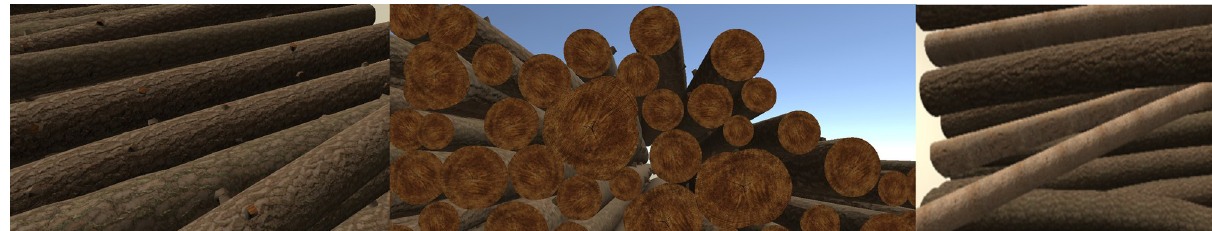
Fig 7. Simulation details: Branch stubs, butt swells, debarked logs (from left to right).